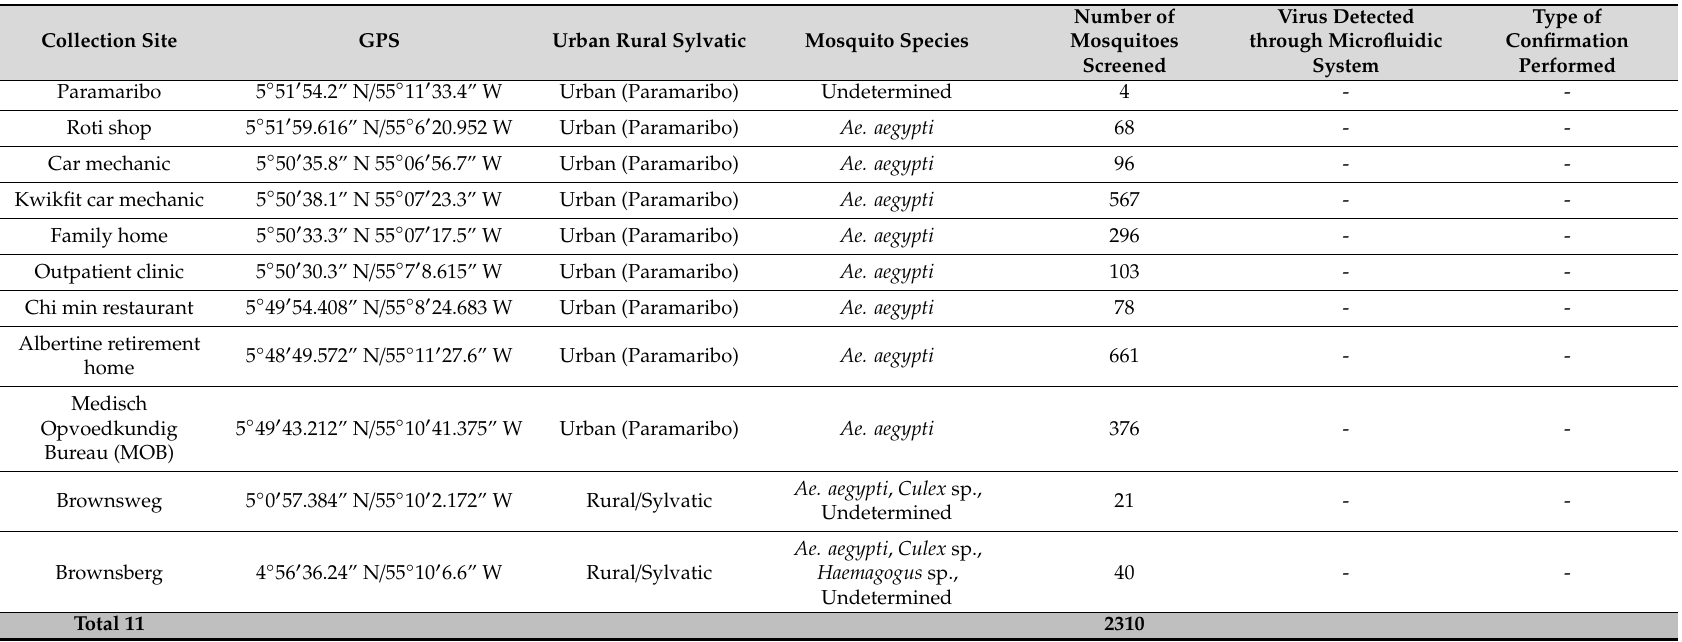
Table 6. Mosquito species, number of mosquitoes collected, and virus detected in